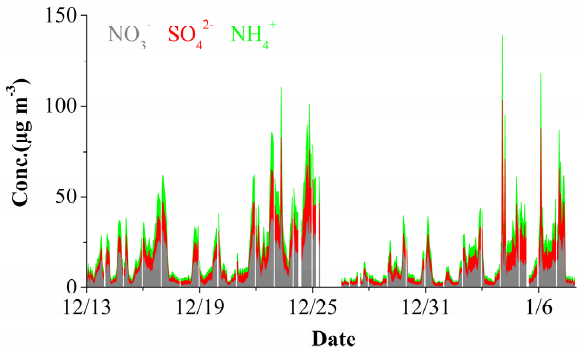
Figure 3. Time series of PM 1 components (sulfate, nitrate, and ammonium).